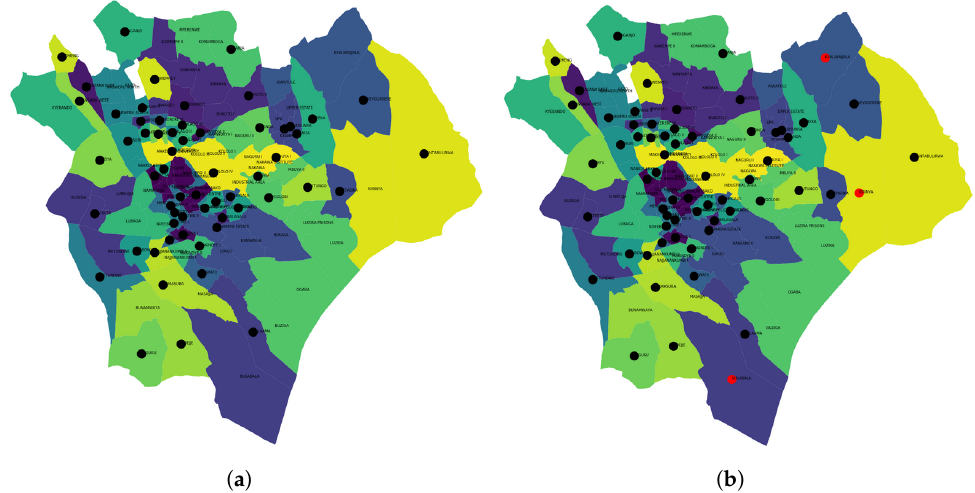
Figure 4. Proposed installation sites that are recommended by the sensor placement model. ( a ) Initial sensor placement. ( b ) Refined sensor